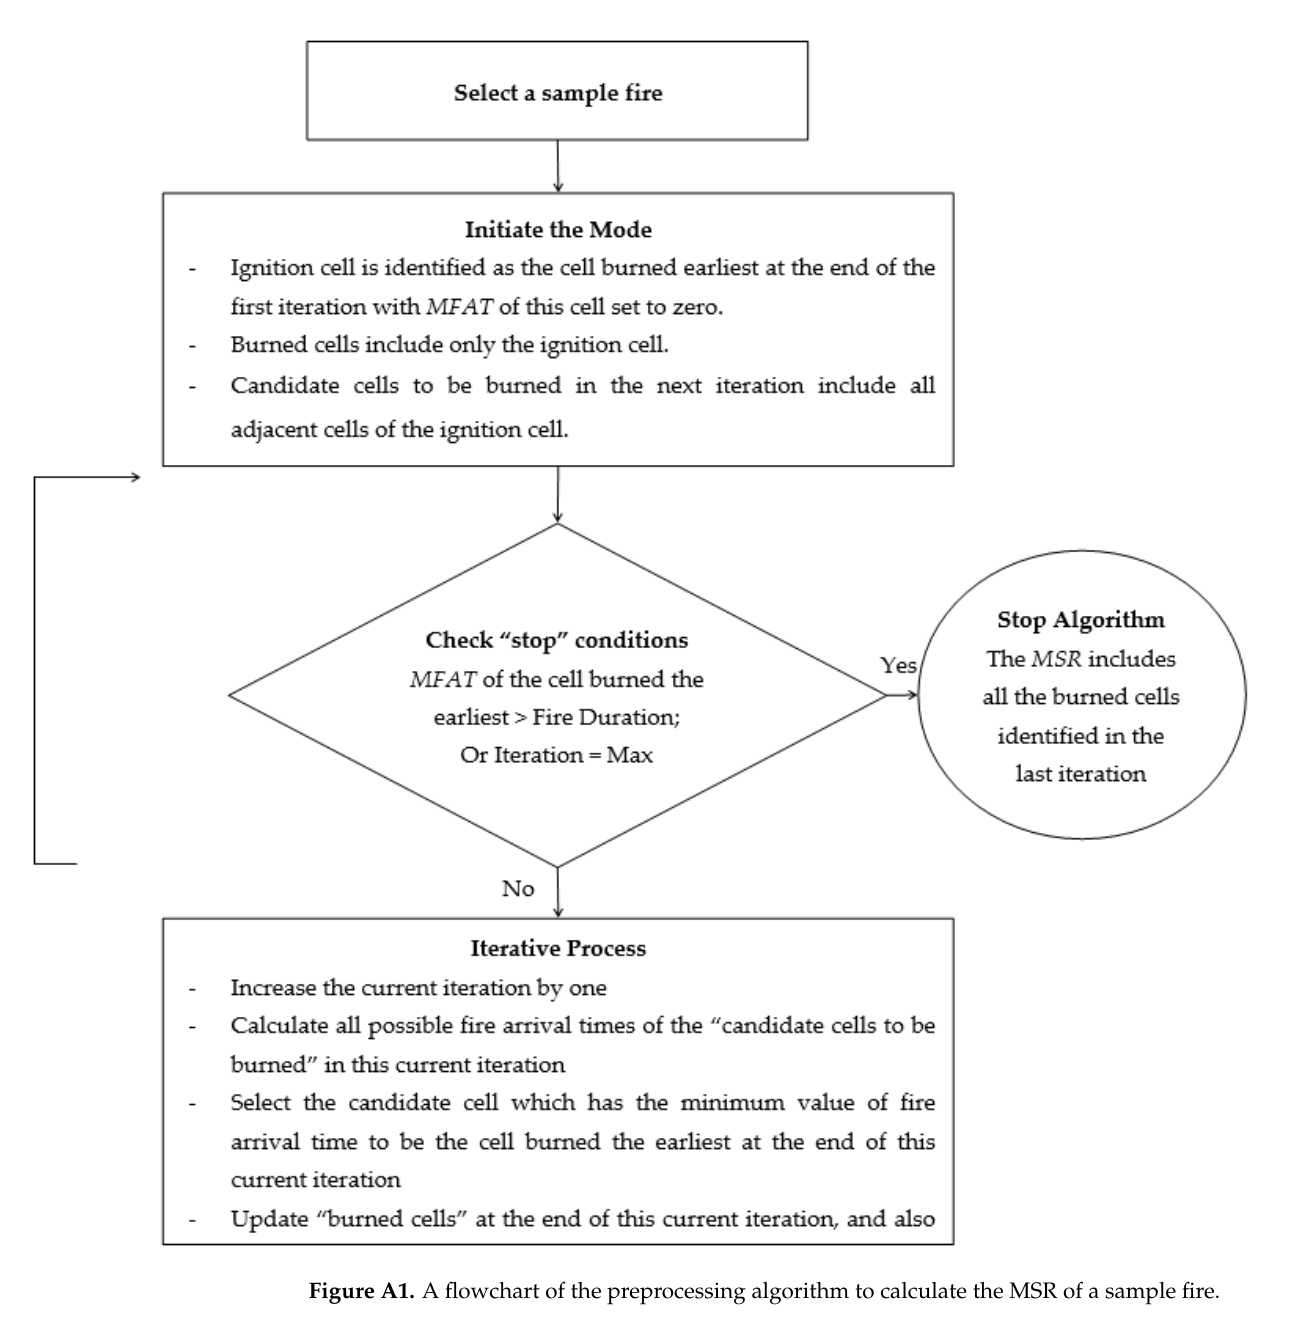
Figure A1. A flowchart of the preprocessing algorithm to calculate the MSR of a sample fire.